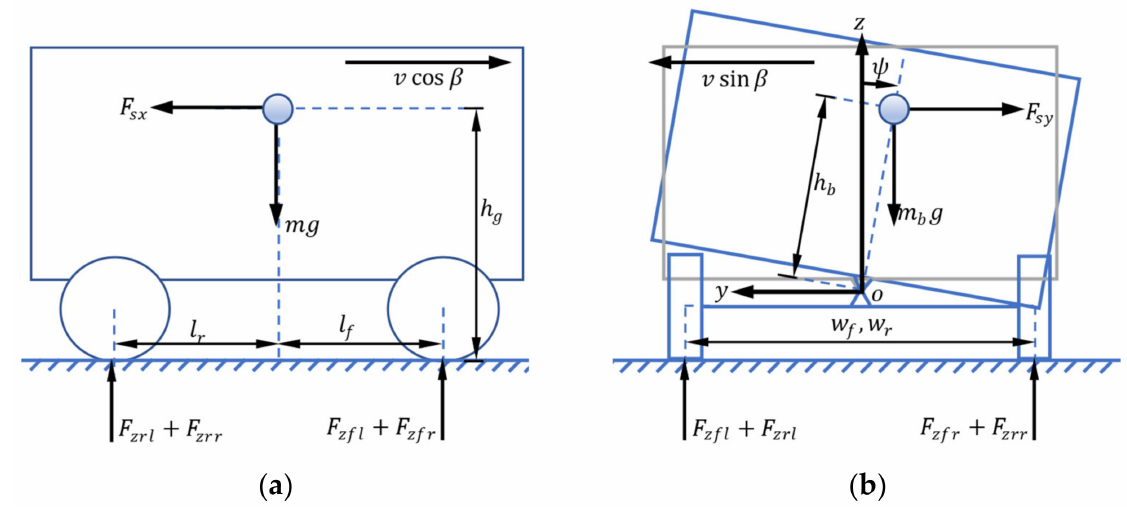
Figure 3. The vertical load transfer: ( a ) the longitudinal movement caused; ( b ) the lateral and active roll movements